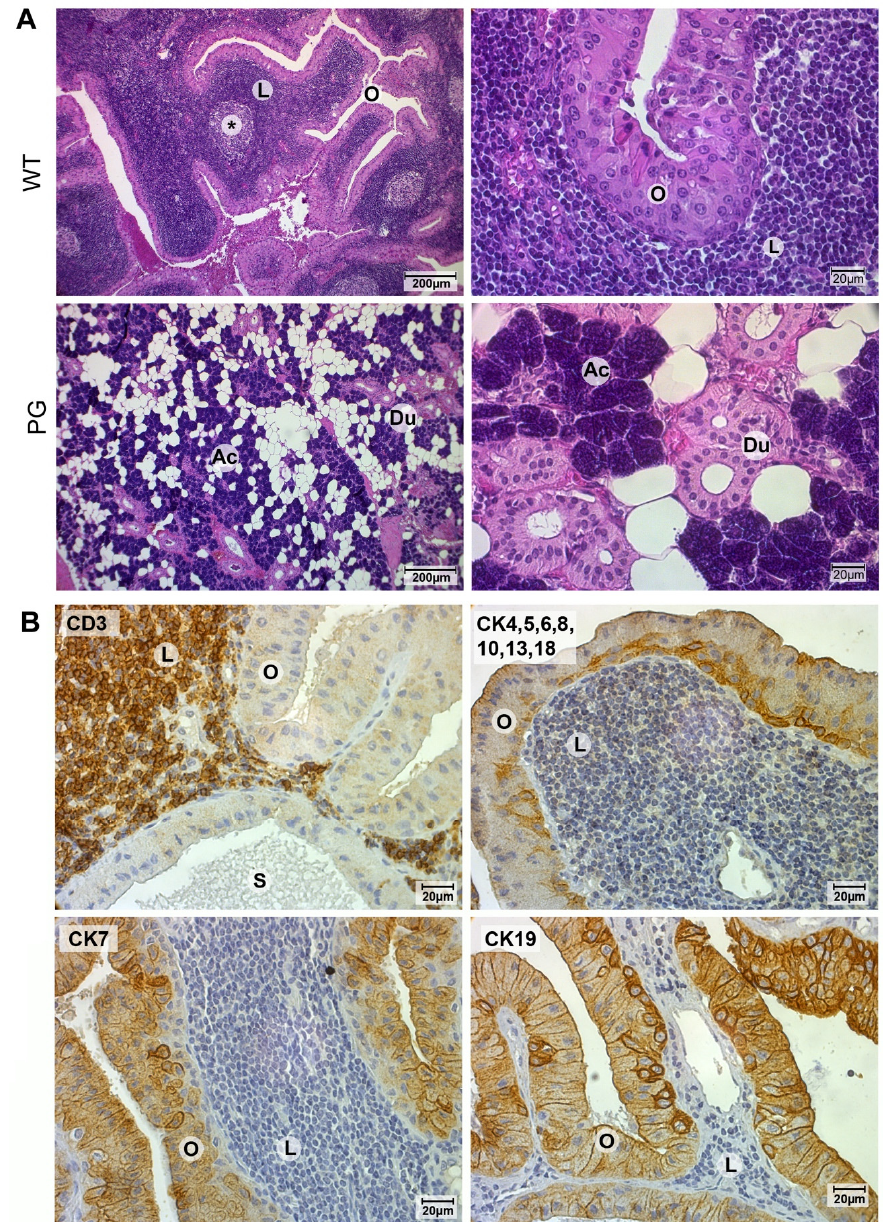
Figure 1. Typical histomorphological features of Warthin tumors. ( A ) Hematoxylin-and-eosin staining of Warthin tumor (WT) tissues reveals the two major cellular components, stromal lymphocytes (L) forming germinal centers (*) and epithelial oncocytes (O). The major cellular structures seen in normal parotid gland (PG) tissues are acini (Ac) and ducts (Du). ( B ) Immunohistochemical analysis using lymphocyte (CD3) and several epithelia (CK) targeting antibodies specifically mark lymphocytes (L) and oncocytes (O), respectively. S = secretion.